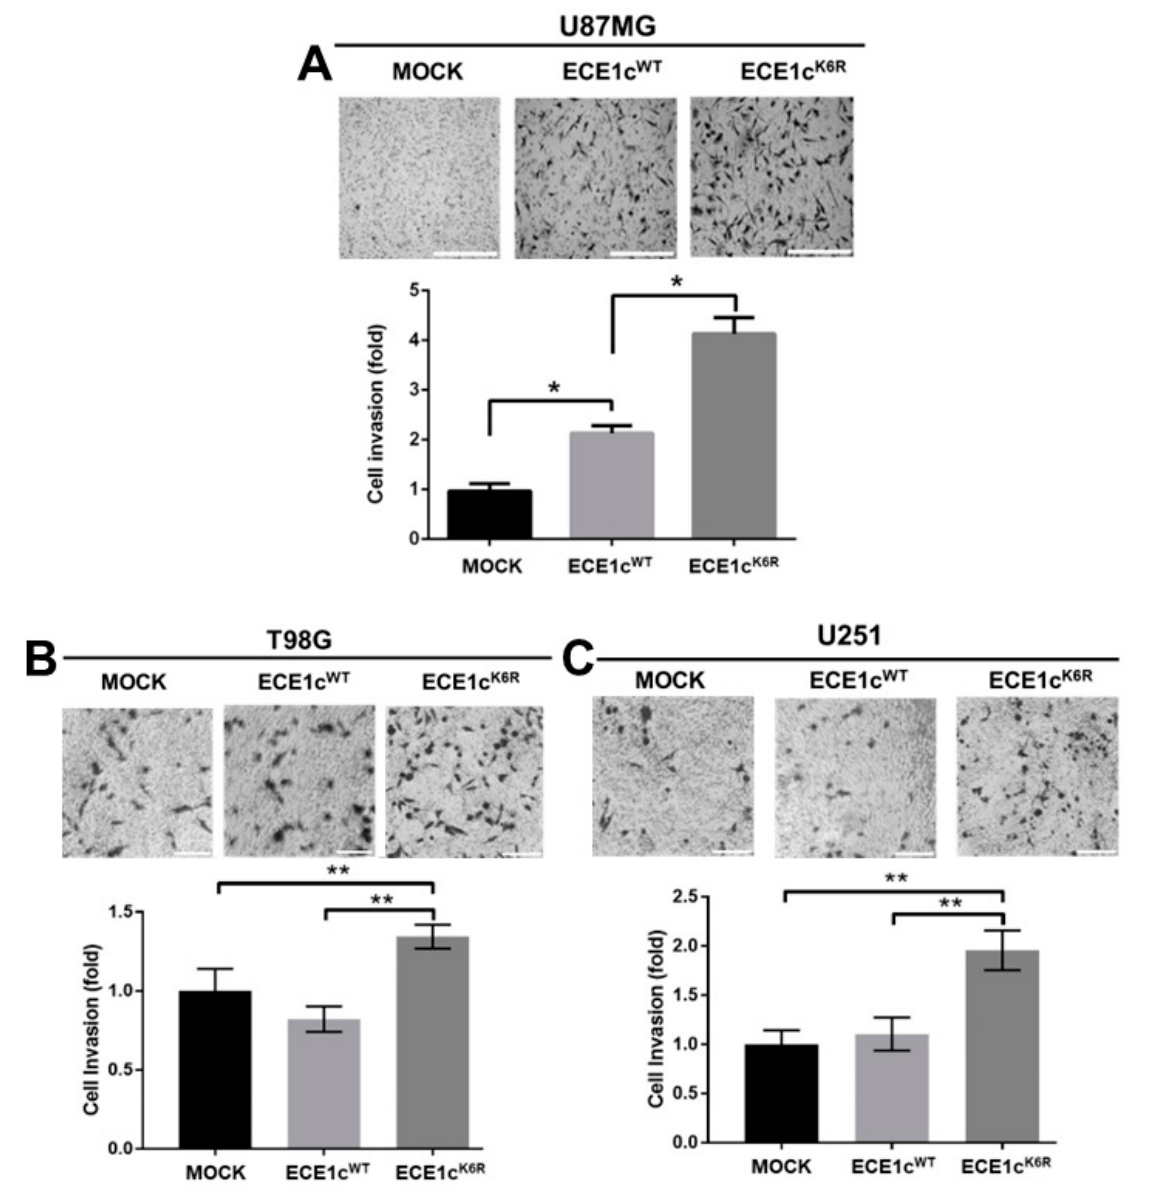
Figure 8. Cell invasion was improved in GBM cells expressing ECE1c K6R . Cell invasion was evaluated using a Matrigel-coated assay in mock, ECE1c WT -expressing, and ECE1c K6R -expressing U87MG ( A ), T98G ( B ), and U251 ( C ) clone cells grown in normal conditions for 6 h. Cells were grown in normal conditions at 37 °C for 6 h with 10% FBS as a chemoattractant. Then, the invaded cells were fixed and stained with crystal violet. Cells were counted using the 4X objective in 5 different fields, mock normalized to 1, and plotted as fold changes. Data represent averages ± SEMs ( n = 3). Peritz F and Student’s tests were used. * p ≤ 0.05, ** p ≤ 0.01.